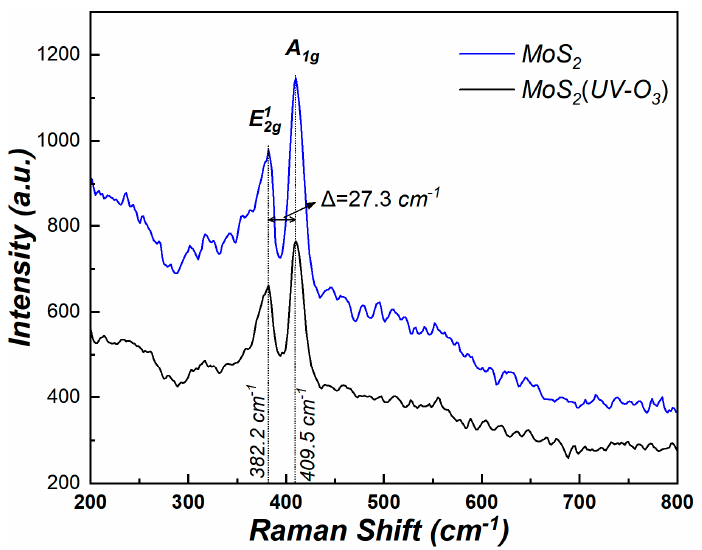
Figure 1. Raman spectra of MoS 2 before and after UV-O 3 treatment.